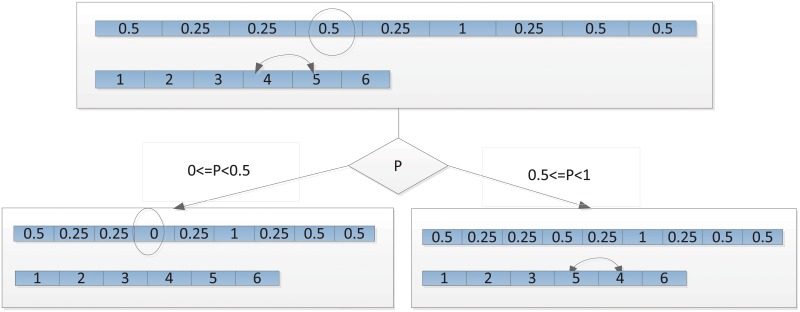
Mutation Operation of Genome S.